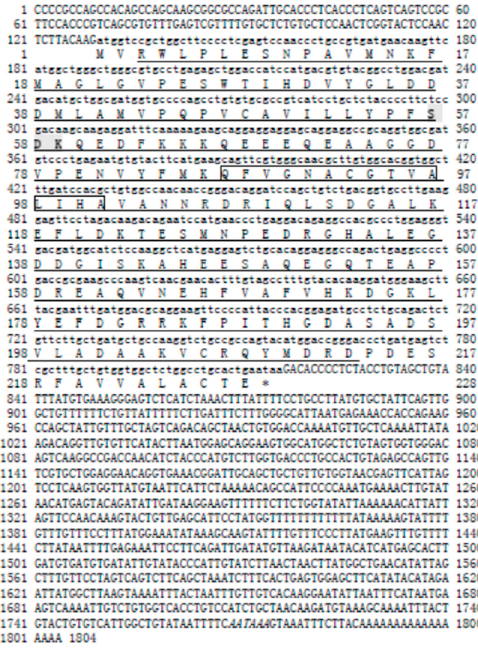
Figure 1. The cDNA and deduced amino acid sequence of Sp-uchl3. The capital bases represent the non-coding region. The small bases represent the open reading frame. The conserved sequence of the UCHL1 family is underlined, the phosphorylation site of protein kinase C is indicated by shadow and bold (S 57 –K 59 ), the active site of ubiquitin carboxyl-terminal hydrolases family 1 is in the box (Q 87 –A 103 ), and the polyadenylation signal (AATAA) is marked by italics.